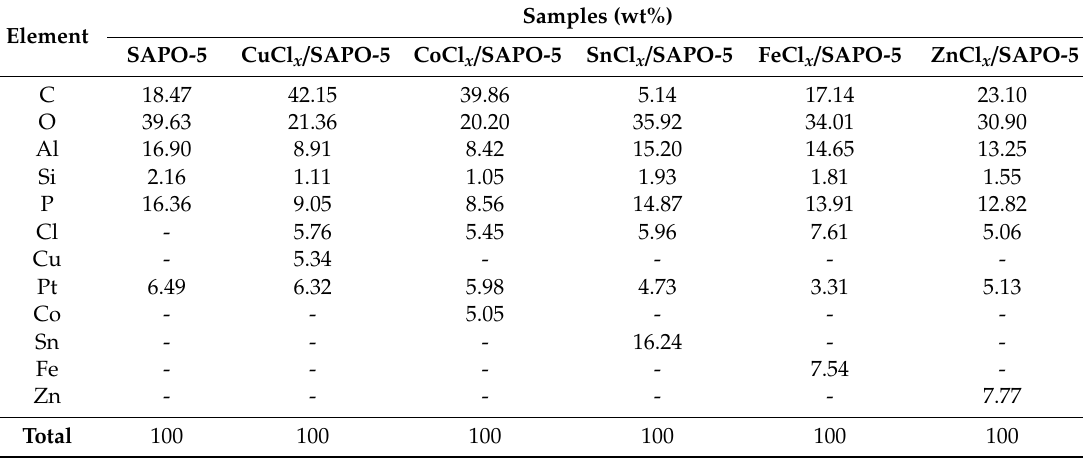
Table 1. Chemical compositions of metal chlorides supported on